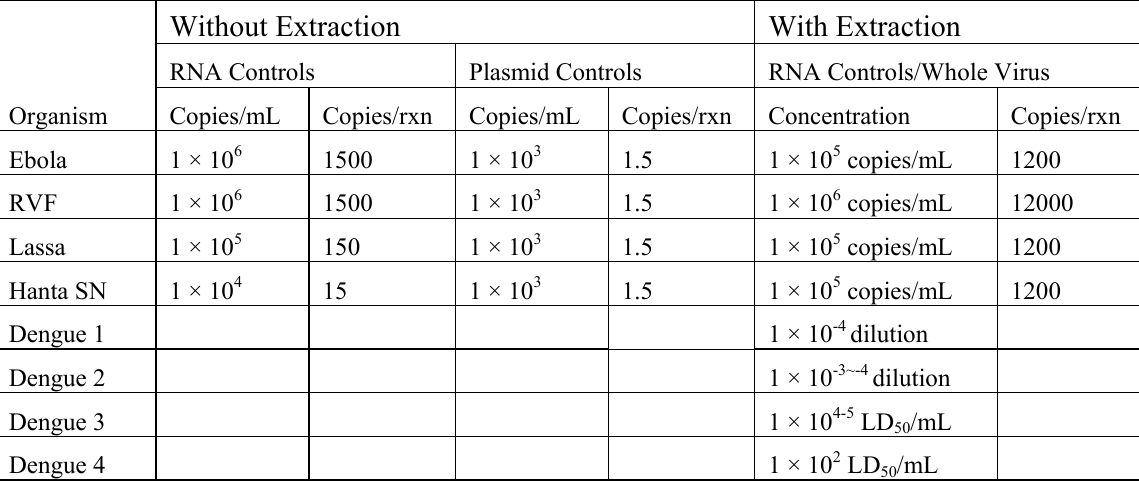
Table 2. The limits of detection of the BioT RNA assay for RNA transcript control, plasmid controls, or whole